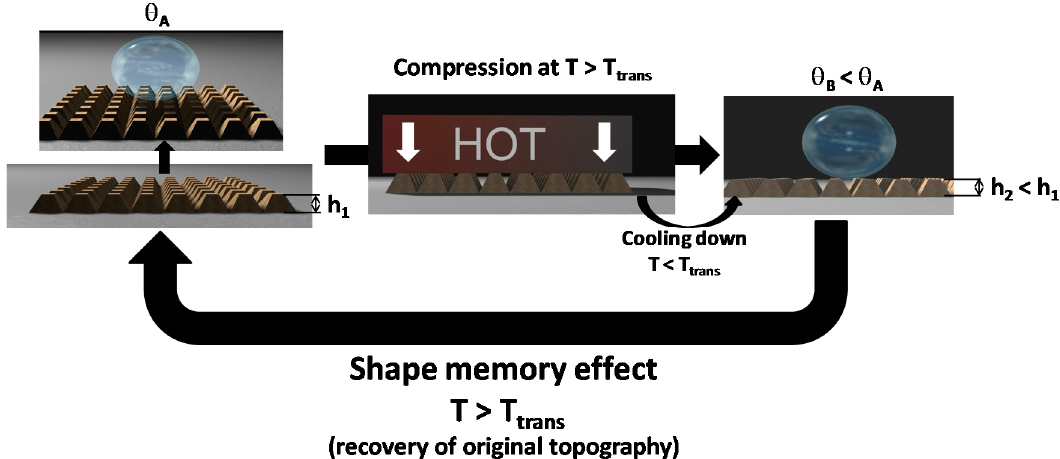
Figure 1. Schematic illustration of switching wettability from thermally induced surface shape memory recovery (from water contact angle θ A to θ B by compression, and recovery of the original θ A by heating).